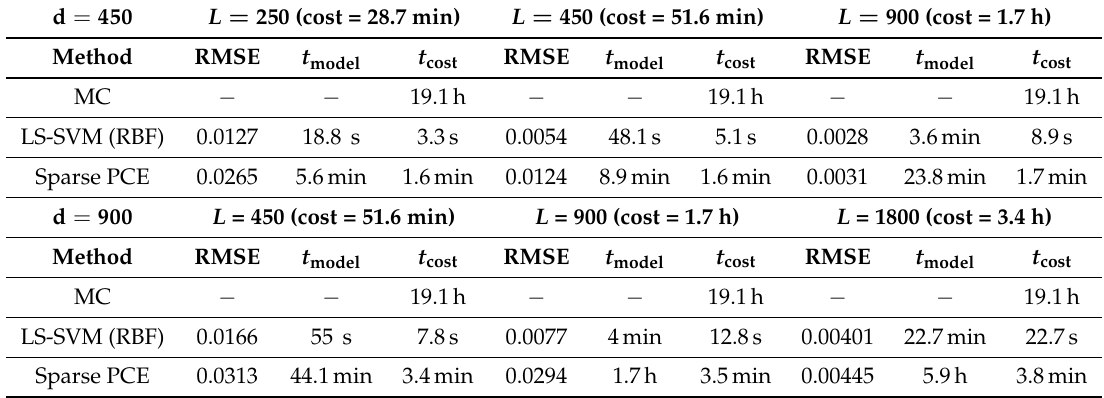
Table 1. Modeling performance in terms of accuracy and efficiency for different training set sizes. d = 450 L = 250 (cost = 28.7 min) L = 450 (cost = 51.6 min) L = 900 (cost = 1.7